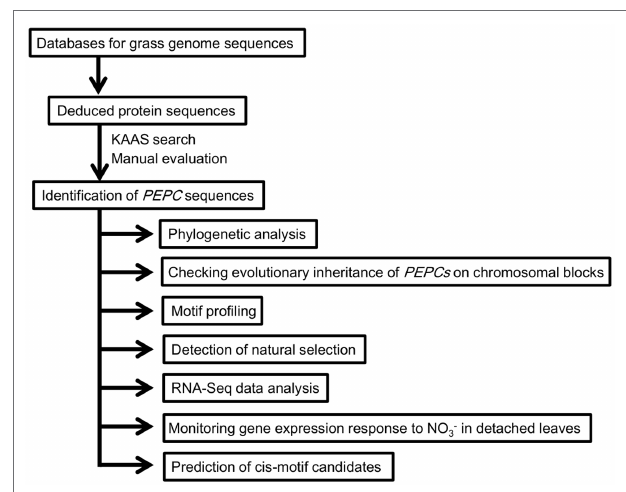
FIGURE 1 | Schematic representation of cross-species genome-wide analysis of grass Phospho enol pyruvate carboxylases